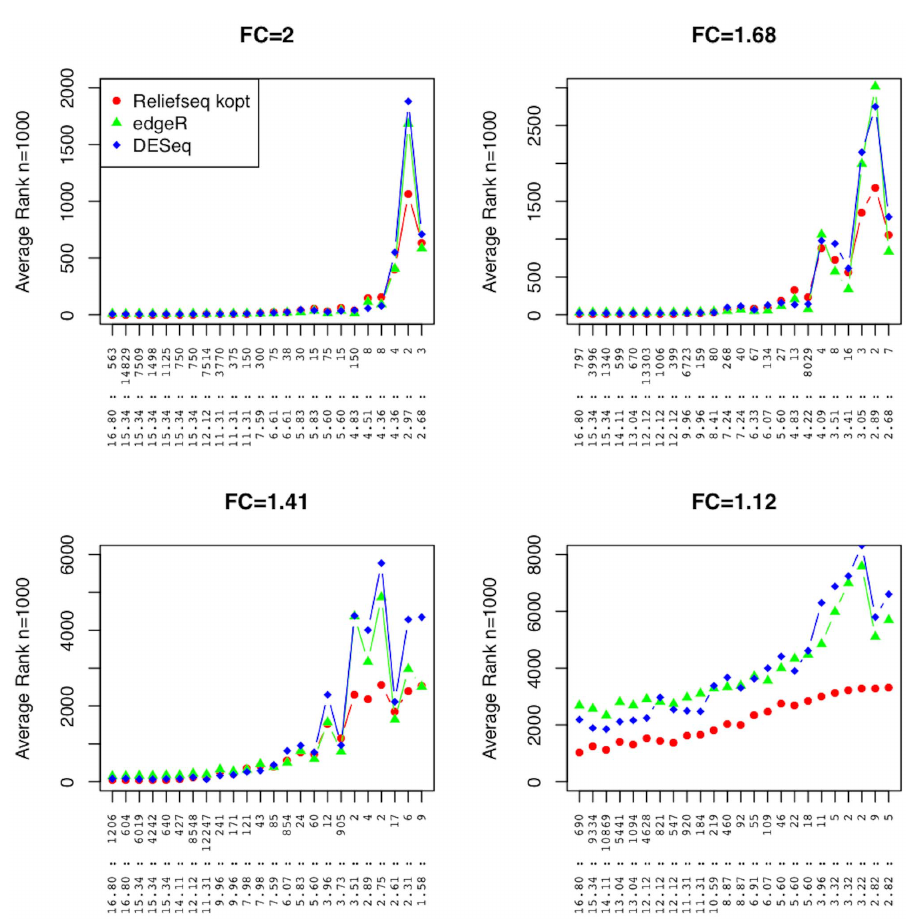
Figure 6. Main effect simulation results comparing gene-wise adaptive-k ReliefSeq, edgeR, and DESeq. Average ranks of the 96 main effect genes simulated in each data set with a total of 16,920 genes for Relief-F with optimized k nearest neighbors, edgeR, and DESeq. The results are split into four panels based on fold change (FC) on the raw scale. The horizontal axis shows the 96 simulated main effect genes, ordered left to right from high to low main effect strength, and labeled by the combination of negative binomial parameters ( h : m ) of the main effect gene. Each point is the average rank across n=1000 replicate simulations (vertical axis).